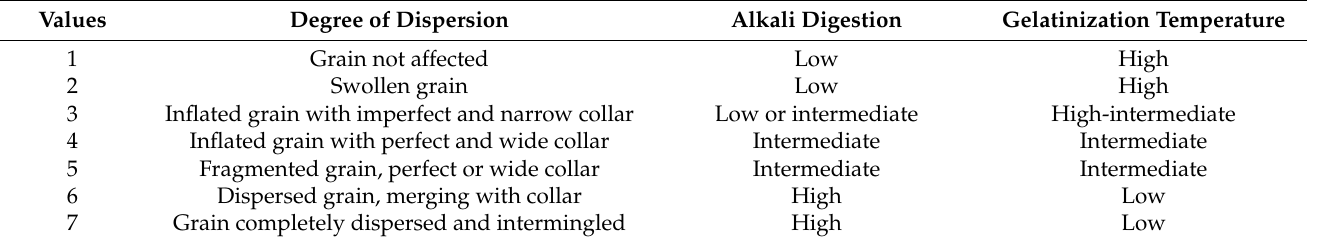
Figure 1. Degree of alkali digestion in rice seeds. Table 1. Numerical scales for scoring gelatinization